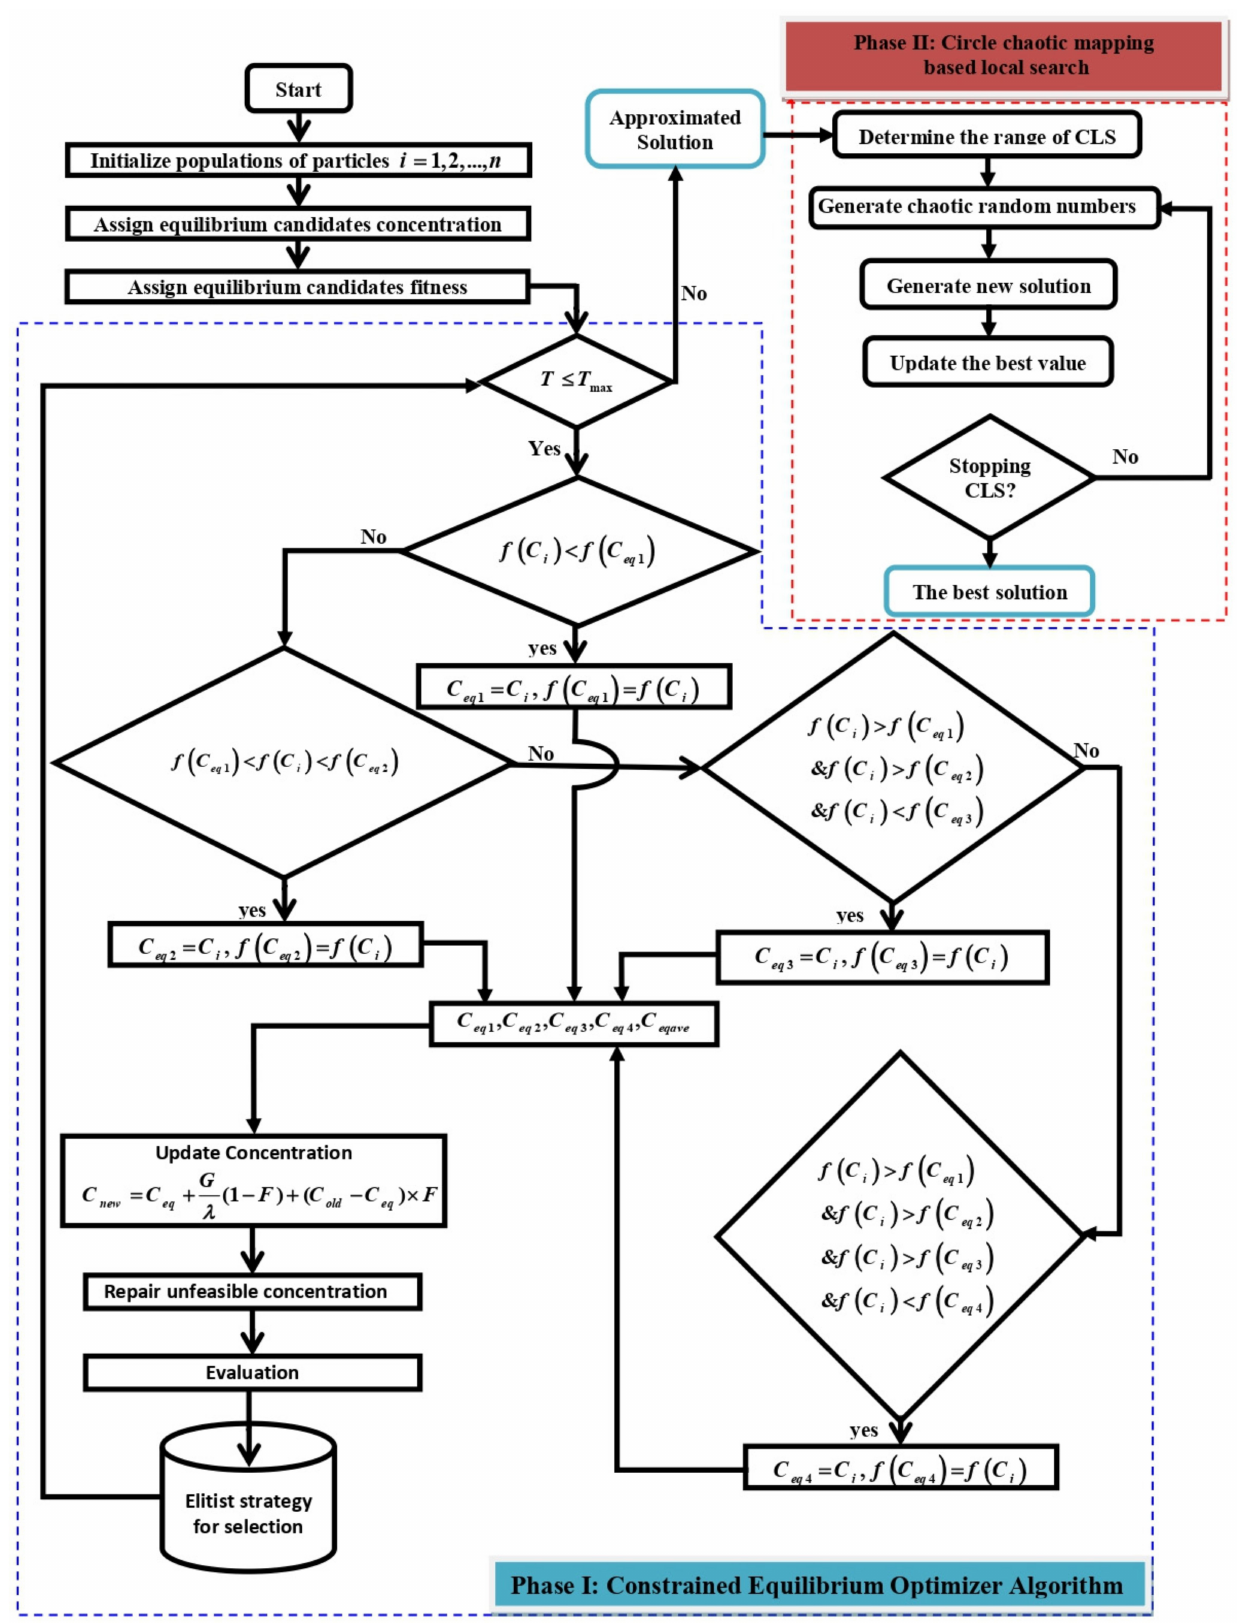
Figure 2. Flowchart of the proposed